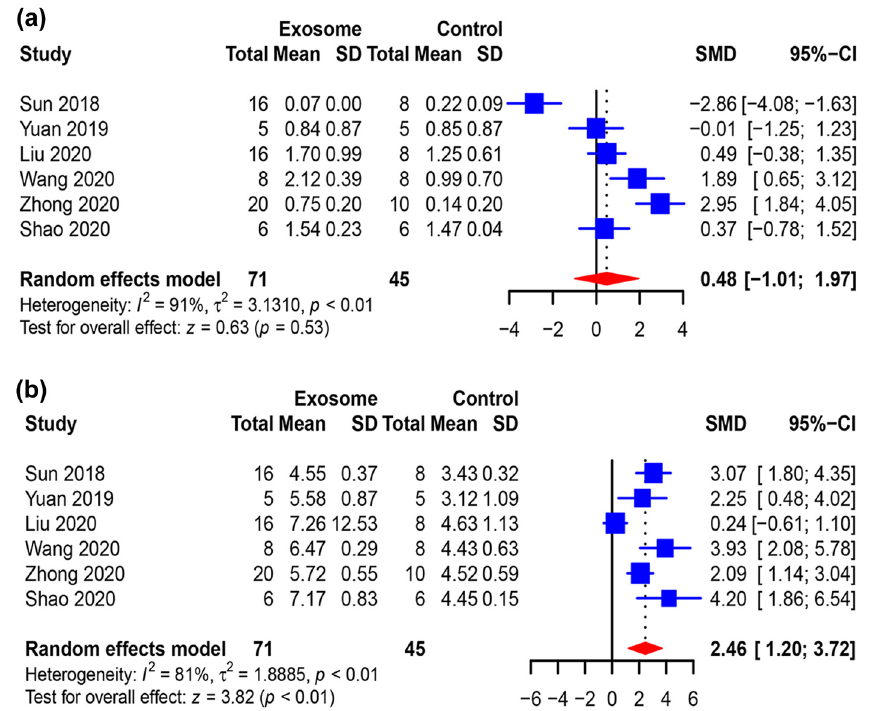
Figure 4: Pooled - analysis of Basso Mouse scale at the fi rst ( a ) and last measurement ( b ) after SCI. SMD, standard mean di ff erence; SD, standard di ff erence; CI, con fi dential